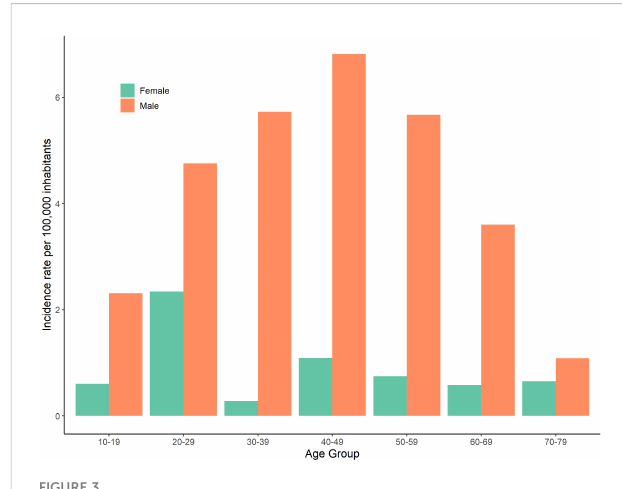
FIGURE 3 Incidence rates per 100,000 of leptospirosis in Denmark by age group and sex,